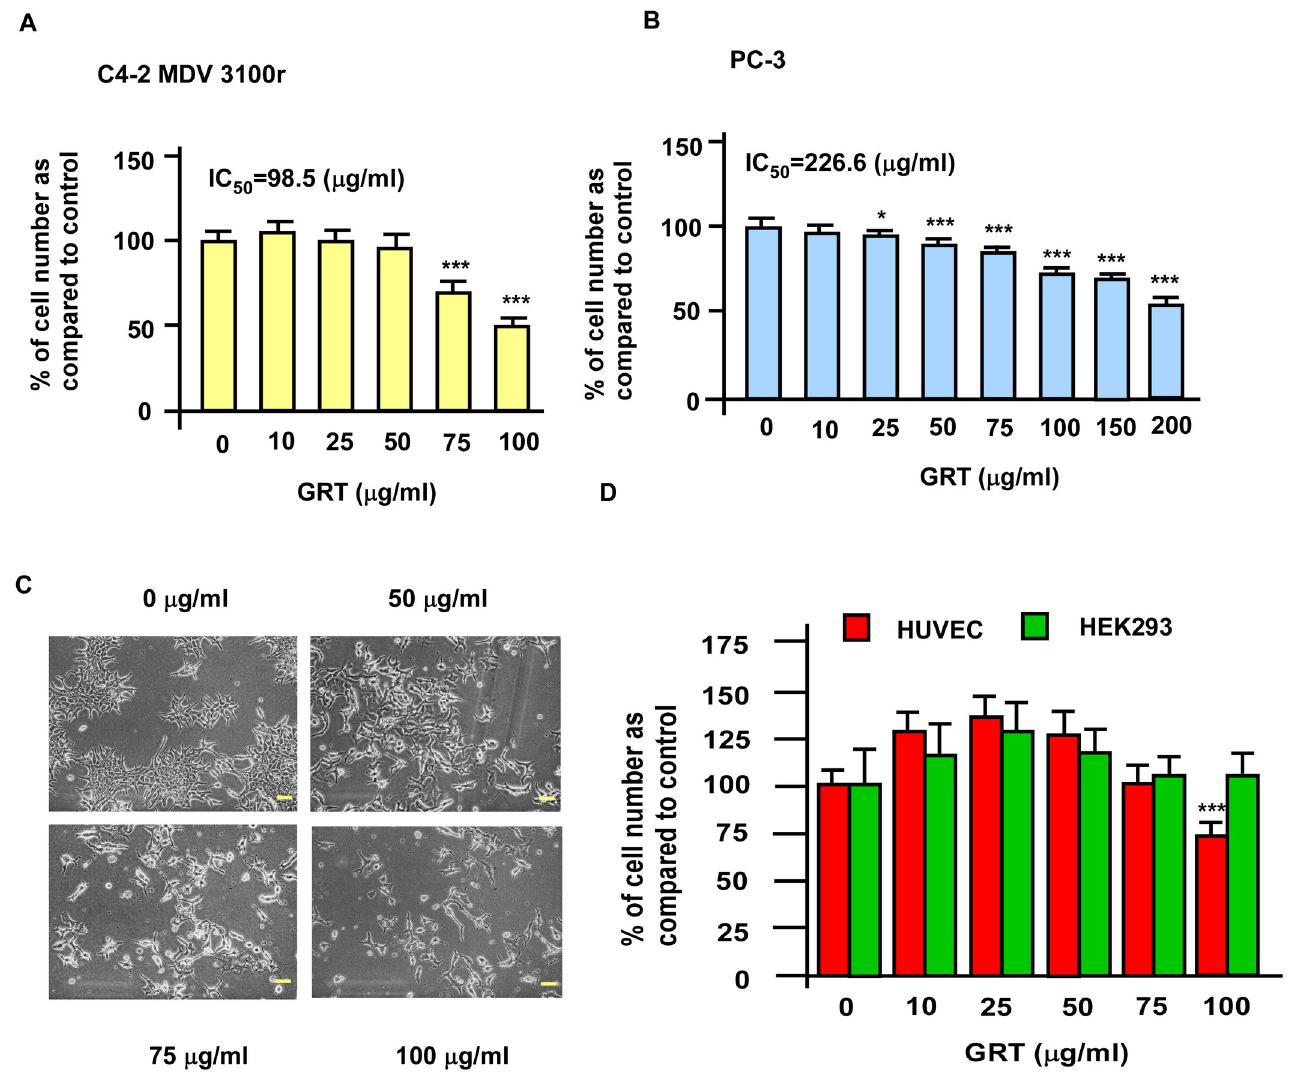
Fig 2. Effects of GRT on proliferation of enzalutamide-resistant C4-2 MDV3100r, PC-3, and non-cancerous human cell lines. Proliferation of LNCaP C4-2 MDV3100r (A) and PC-3 (B) being treated with increasing concentration of GRT (0–100 μ g/ml for C4-2 MDV3100r cells and 0–200 μ g/ml for PC-3 cells) for 96 h was determined by Hoechst 33258 proliferation assay. (C) Morphology of C4-2 MDV3100r cells under treatment of different concentrations of GRT (0, 50, 75, 100 μ g/ml) was examined by microscope. The magnification of the microscope is 100X and the yellow scale bar represented 100 μ m. (D) Proliferation of HUVEC and HEK293 cells being treated with increasing concentration of GRT (0–100 μ g/ml) was determined by Hoechst 33258 proliferation assay. Asterisk � , �� and ��� represents statistically significant difference p < 0.05, p < 0.01 and p < 0.001, respectively, between the two groups of cells being compared.